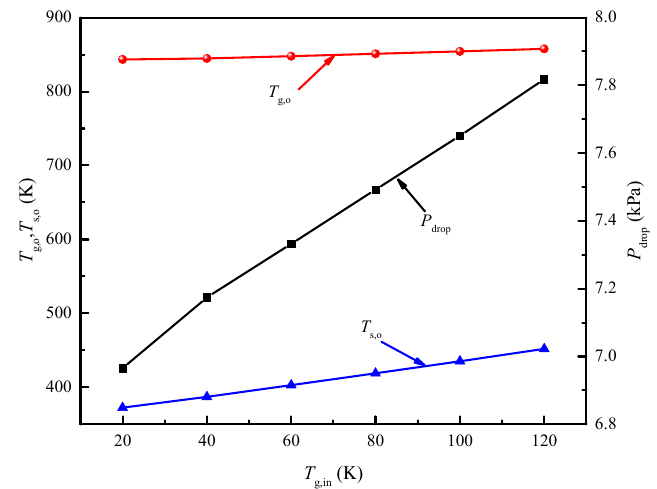
Figure 7. Effects of the air inlet temperature on the air and sinter outlet temperatures and the pressure drop of cooling air.